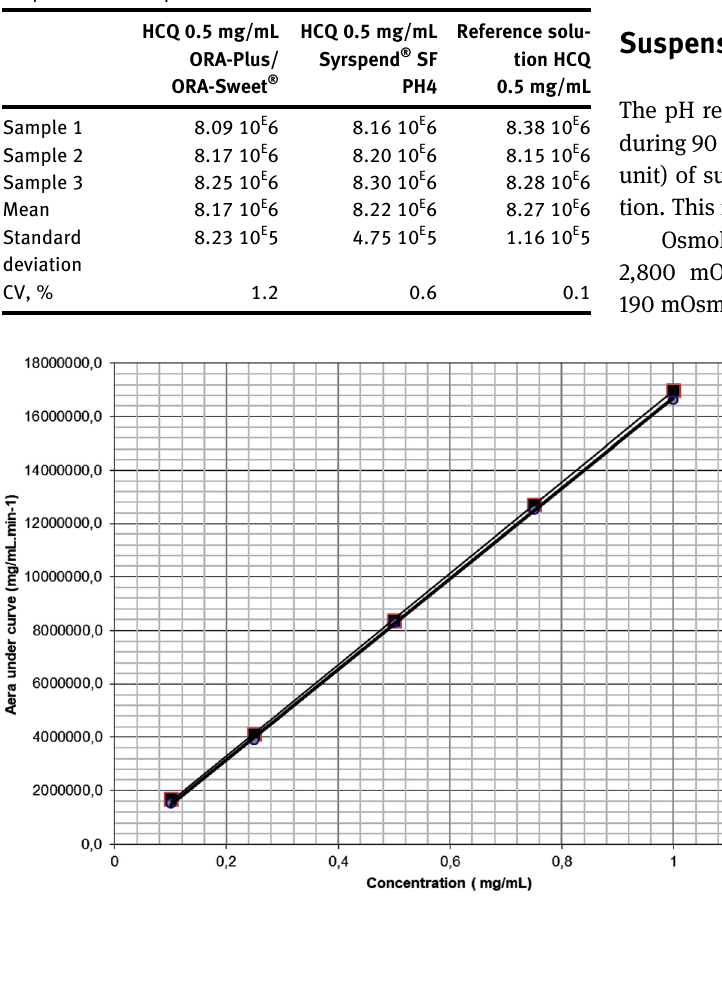
Table  : Area under the curve (AUC) of different samples after preparation before analytical assays for each hydroxychloroquine suspension in comparison with the reference solution.